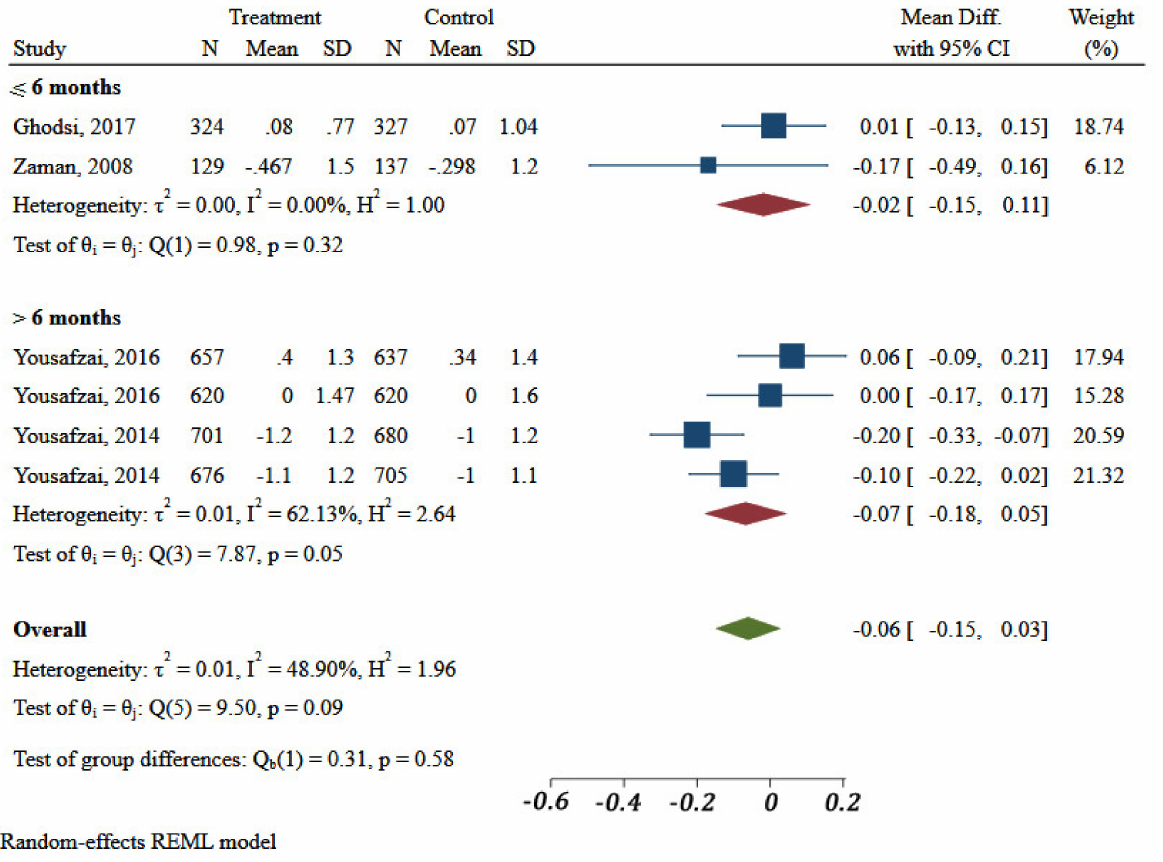
Figure 3. Impact of different community-based nutrition intervention duration on Height-for-Age Z-score of children under 5 in Eastern Mediterranean